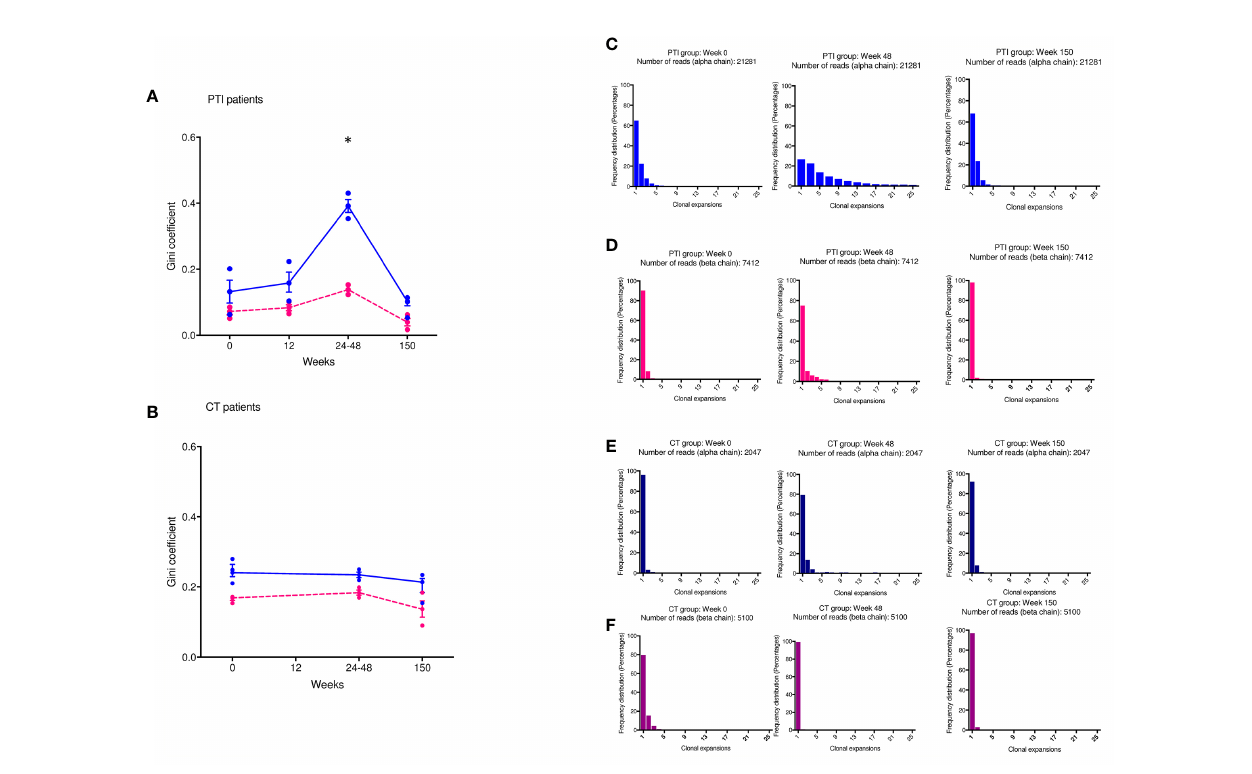
FIGURE 2 | Changes in TCR abundance distribution in naïve CD4 + T cells during ART treatment interruption. (A, B) The degree of clonal expansion in the TCR repertoire measured using the Gini coef fi cient in TCR a (blue) and TCR b sequences (pink) in the PTI (A) and CT (B) group. (C – F) TCR sequence abundance distribution in representative individuals. (C, E) TCR a ; (D, F) TCR b . (C, D) PTI group; (E, F) CT group. TCR b [pink individual Gini coef fi cients and dotted lines connecting median(IQR)] and TCR a [blue individual Gini coef fi cients and solid lines connecting median(IQR)]. *P ≤